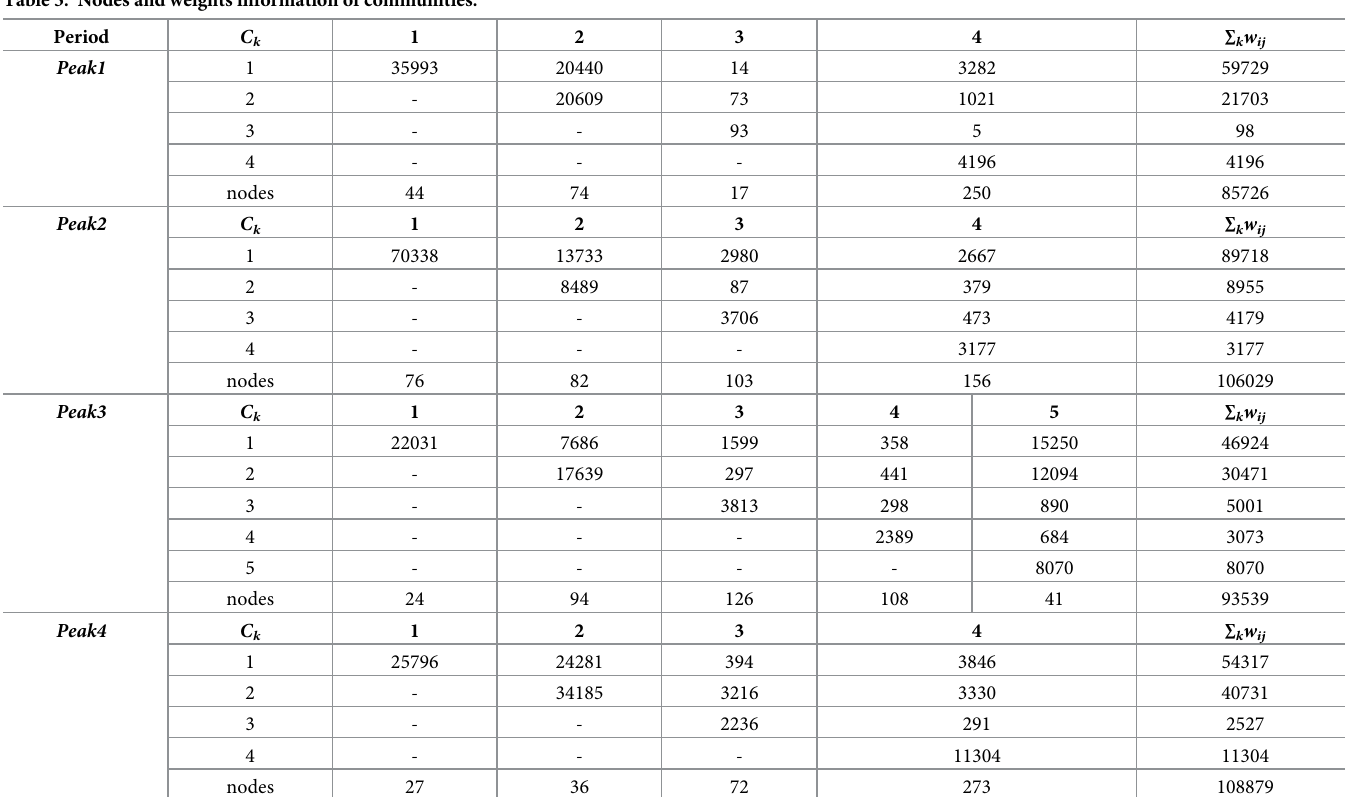
Table 3. Nodes and weights information of